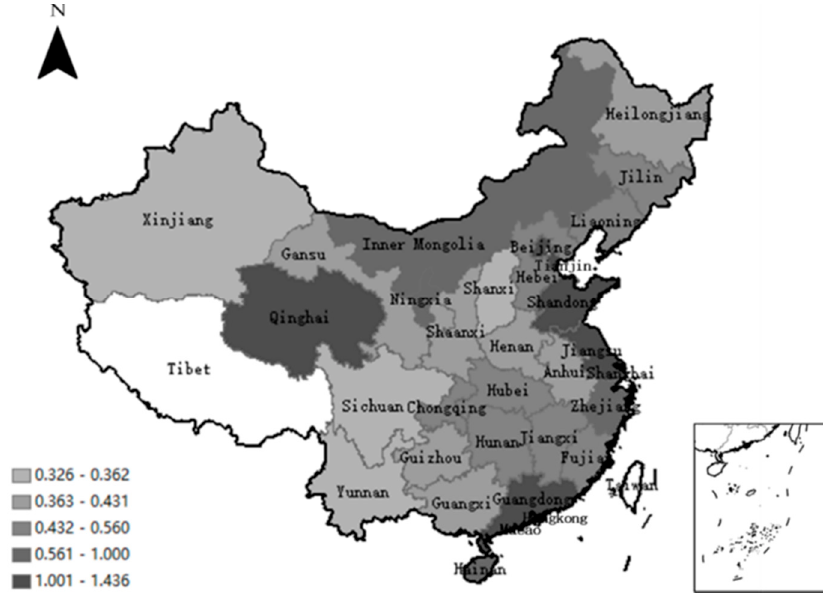
Figure 2. Spatial distribution of average green economic efficiency from 2008 to 2017.